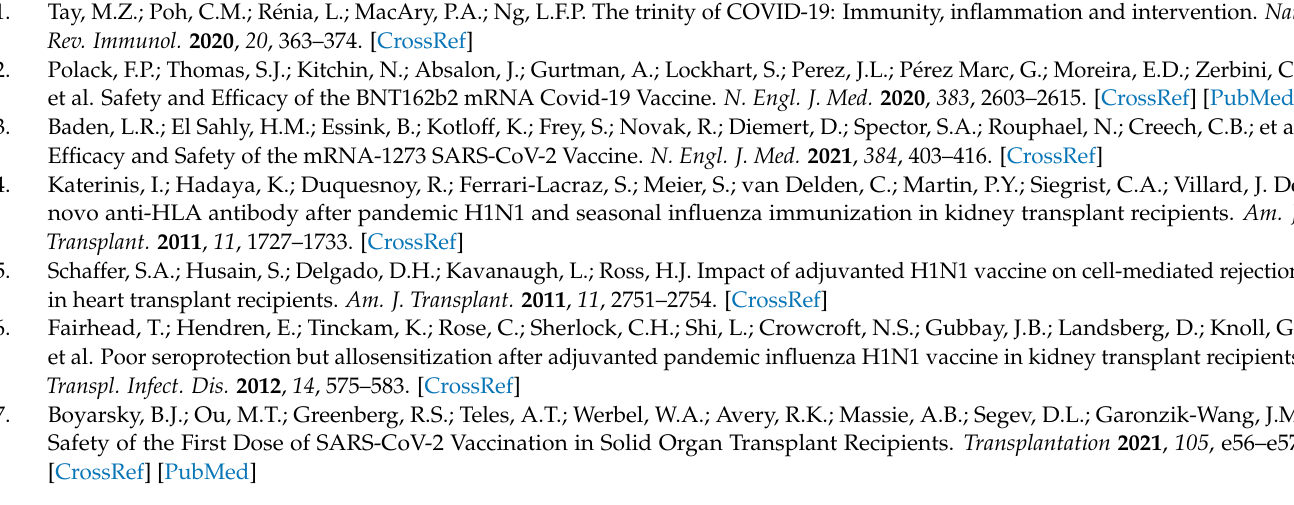
Ab after 2nd dose